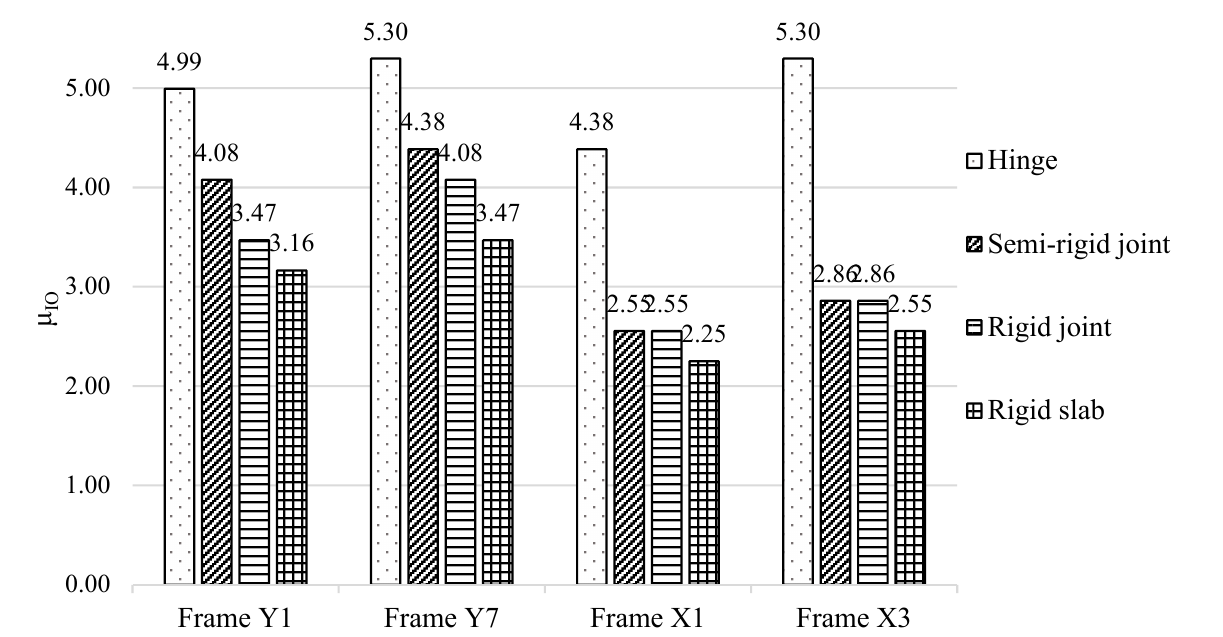
Figure 21. Damage factors of the warehouse with different connection types at the IO limit state.